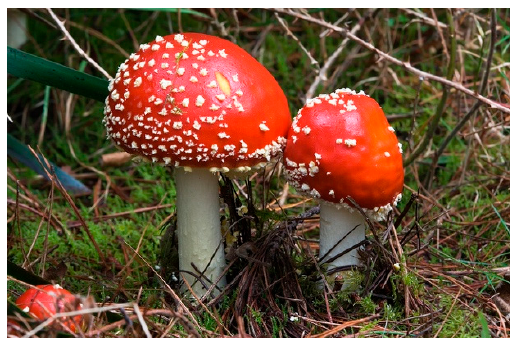
Figure 4. A photo of the Amanita muscaria mushroom with the V(IV)-containing natural product